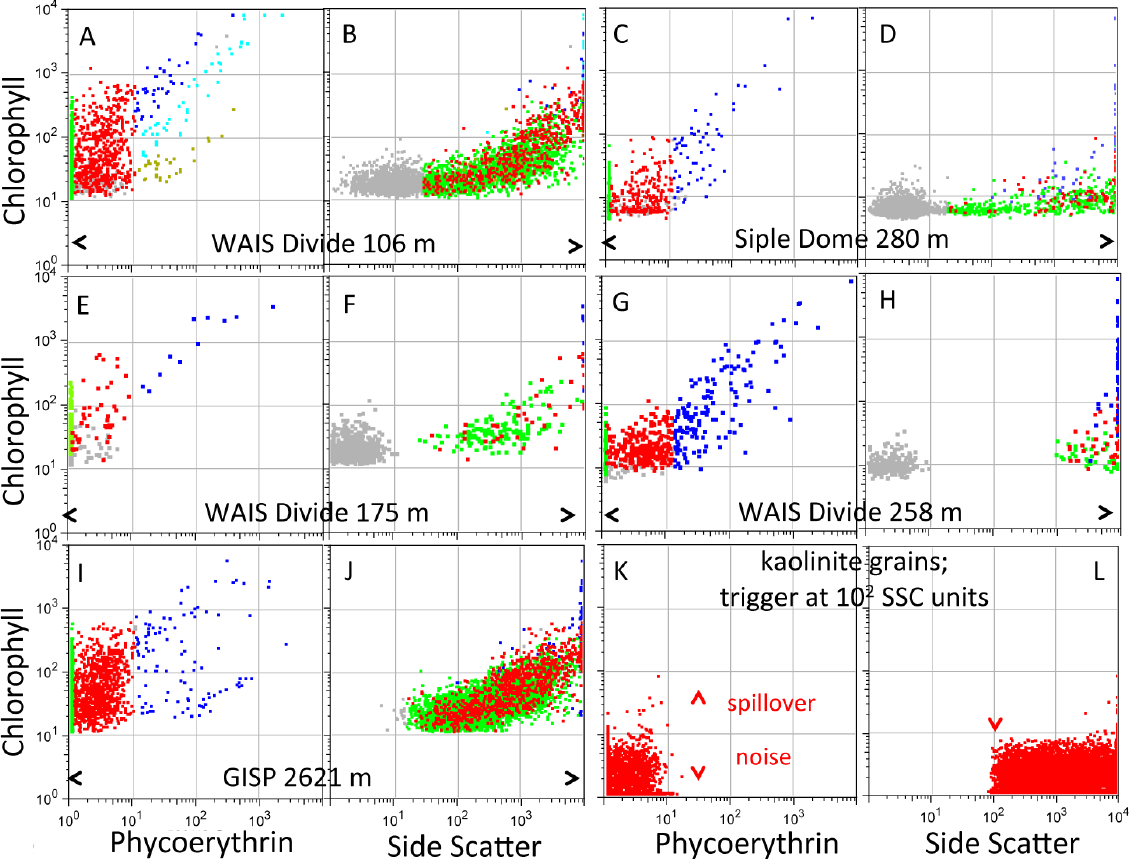
Fig. 8. (A) to (J) show FCM plots of unstained cells from ice cores. Points in gray at low SSC were gated out before plotting Chl vs. PE. The gain on the Chl phototube was set higher for plots ( A, B, E, F, I and J ). Plots of kaolinite grains with trigger on 100 units of SSC are shown in (K) and (L) . See text for discussion. Table 2. Concentrations of various particles in Antarctic and Greenland ice at depths <